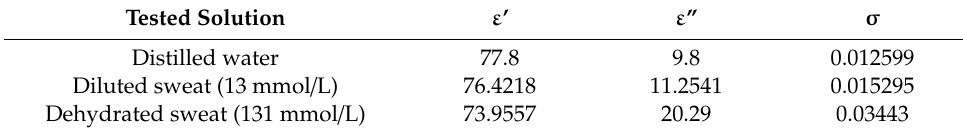
Table 3. Electrical properties for distilled water (DW) and artificial sweat solutions at 2.45 GHz. Tested Solution ε ’ ε ” σ Distilled water 77.8 9.8 0.012599 Diluted sweat (13 mmol / L) 76.4218 11.2541 0.015295 Dehydrated sweat (131 mmol / L) 73.9557 20.29